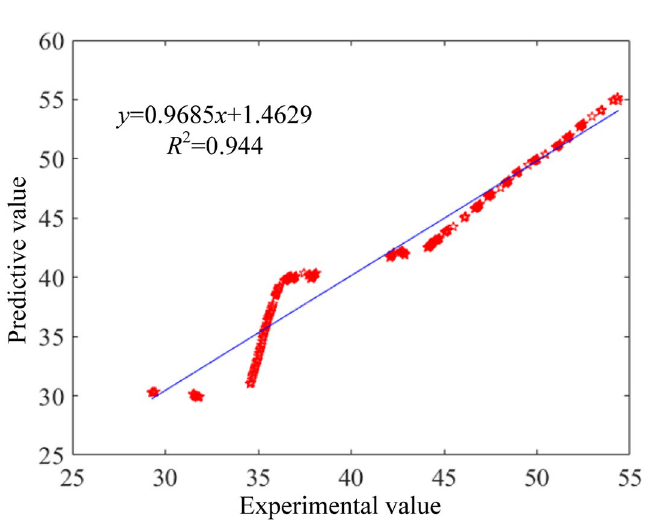
Figure 8. Residual comparison of vibration between predictive and experimental